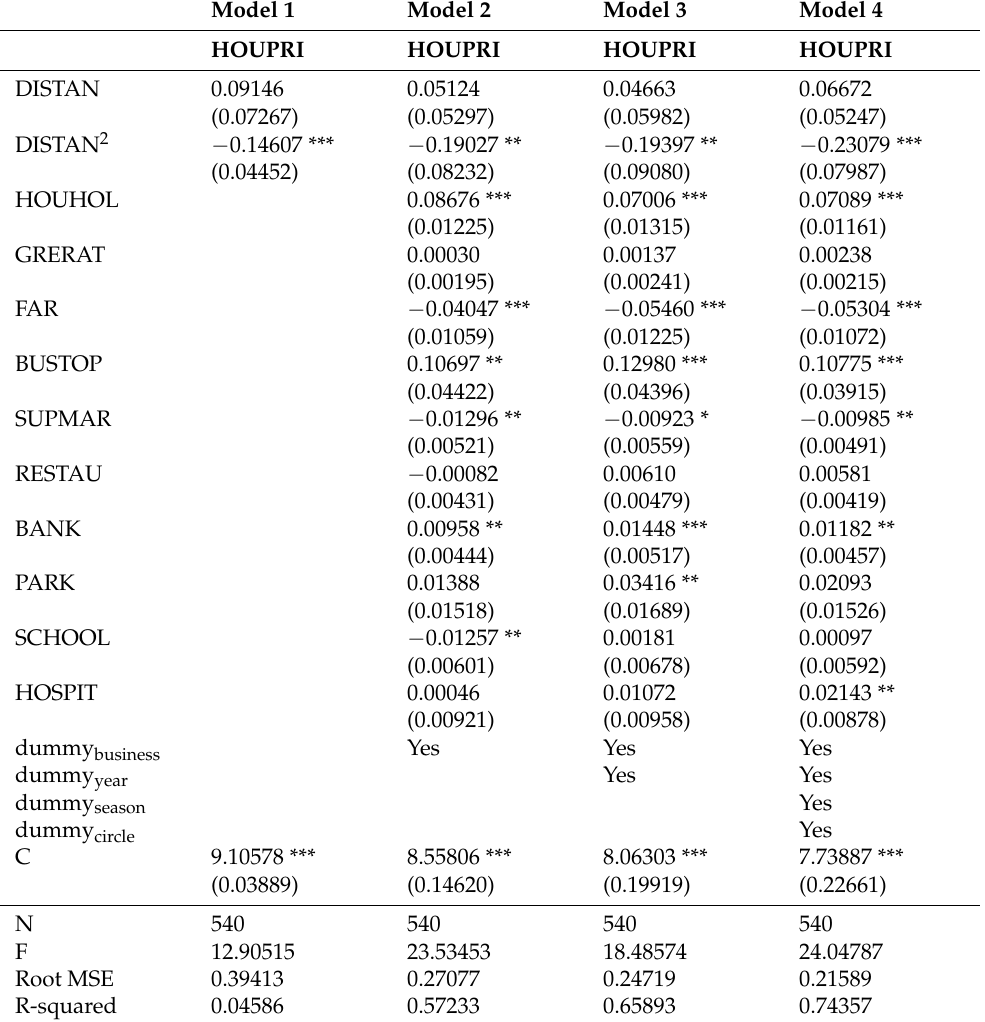
Table 2. Link between the distance to the SFT and housing prices before the release of the assess- ment report.